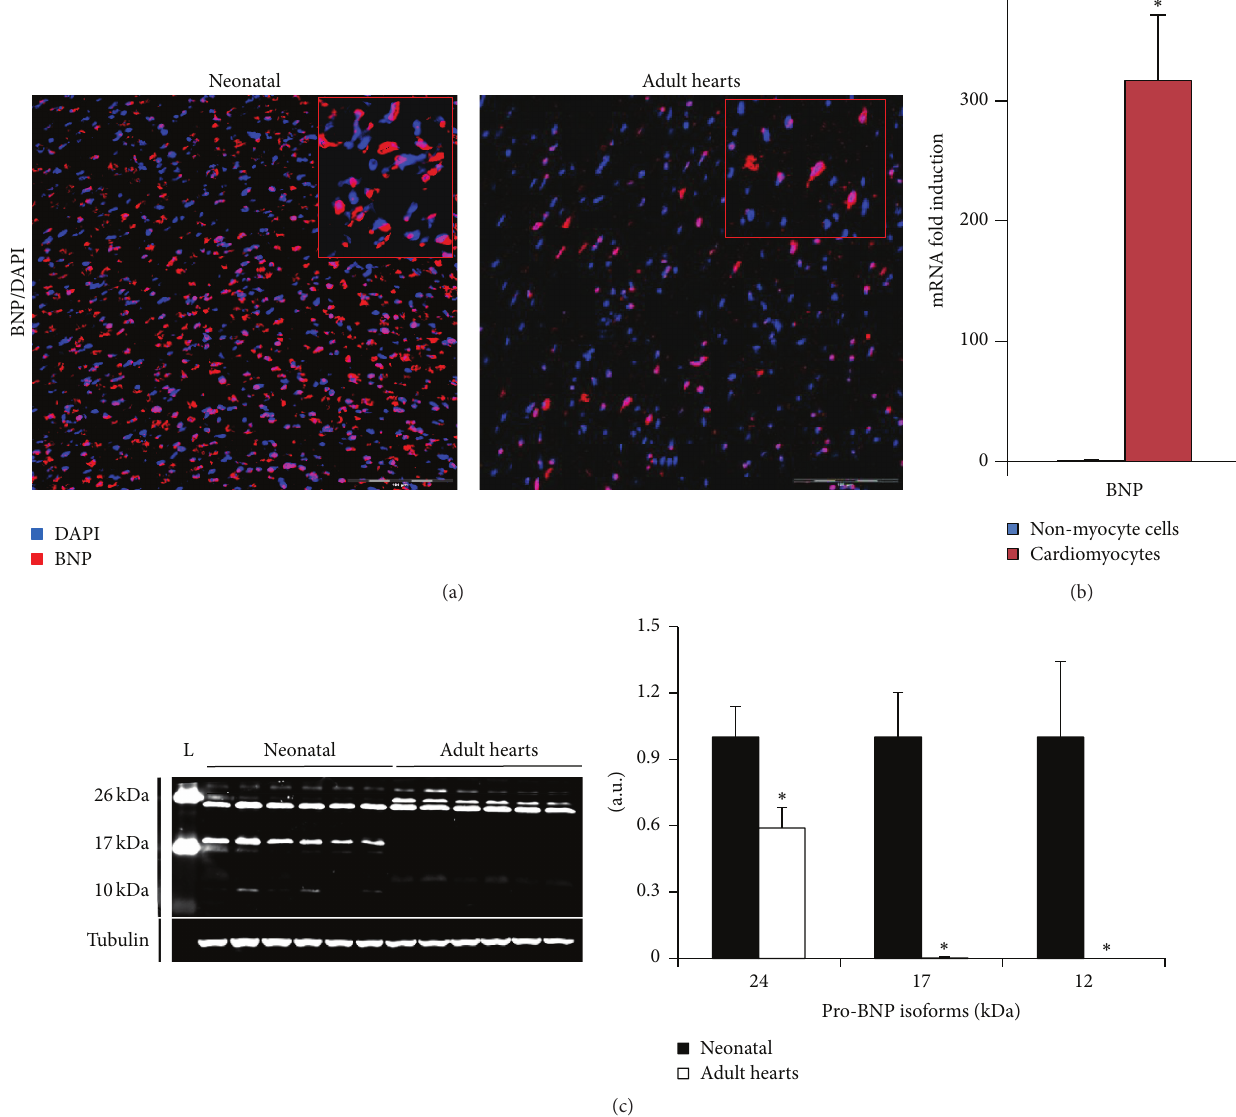
Figure 3: Heart expression of BNP is age-dependent and cell specific. (a) Representative microscopy pictures of neonatal and adult hearts stained for BNP (in red) and DAPI (nuclei in blue). High magnification of positive cells in top right inserts. The scale bars represent 100 𝜇 m. (b) mRNA expression of BNP using quantitative PCR, in non-myocyte cells (NMCs) (blue) and cardiomyocytes (red). Results expressed as fold-increase above the levels in NMCs. 𝑛 = 7 cardiomyocyte samples compared to 9 NMC samples. Data are means ± SEM, ∗ 𝑃 < 0.05 . (c) Determination of BNP protein levels in neonatal and adult hearts by western blot analysis. BNP protein expression with representative western blot and quantification relative to tubulin, expressed as fold changes relative to the average level of neonatal hearts. Data are means ± SEM, ∗ 𝑃 < 0.05 . a.u.: arbitrary